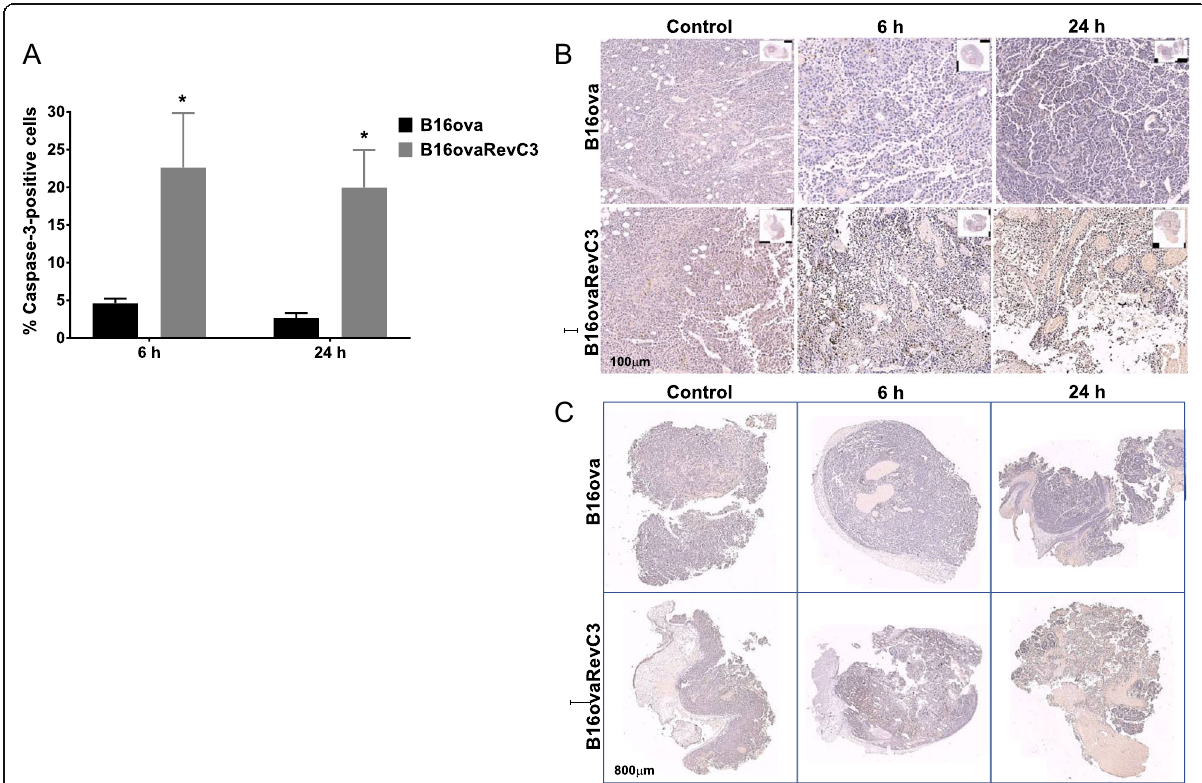
Fig. 6 Cleaved caspase-3 expression after death-switch induction. a Percentage (%) caspase-3-positive cells in B16ova and B16ovaRevC3 tumour sections at 6 and 24h after doxycycline administration. Caspase-3 expression was not detected in control B16ova or B16ovaRevC3 tumours; however, significantly increased caspase-3 expression was observed in B16ovaRevC3 tumours after death-switch induction, which was also significantly higher compared with B16ova tumours from mice treated with doxycycline ( p <0.05 and p <0.05, respectively, multiple t tests). b Representative tumour sections stained for cleaved caspase-3 expression. c Representative whole tumour sections showing a heterogeneous mix of necrosis, immune reaction, patches of tumour cells positive for caspase-3 within a dense stroma, adipose formation and vesicularization following death-switch induction. * indicates significant difference between doxycycline-treated B16ovaRevC3 and control B16ovaRevC3, and doxycycline-treated